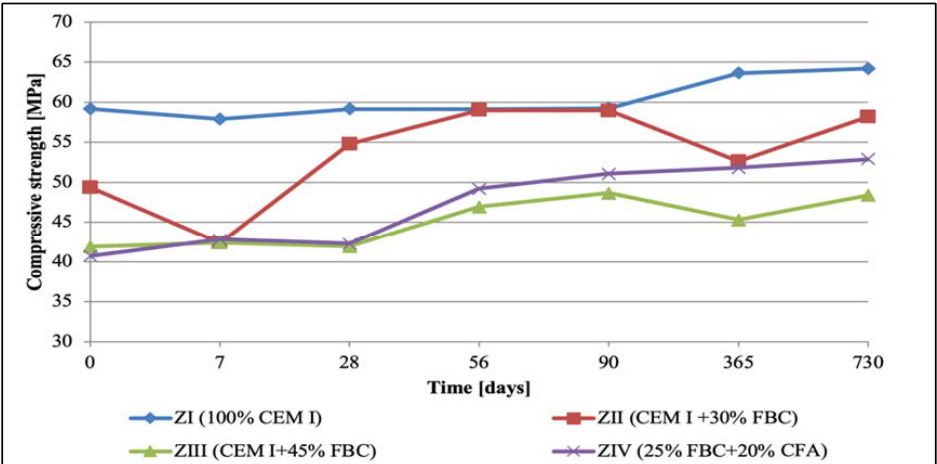
Figure 7. Compressive strength of mortars cured in water for 730 days. At the same time, tests of cement–ash mortars were conducted in an aggressive en- vironment of three solutions of hydrochloric acid with concentrations of 1, 3, and 5%, which had various pH reactions equal to: 2, 1.3, and 0.7, respectively. Observation of the corrosive environment’s impact in case of 1% hydrochloric acid solution (pH = 2) on durability of mortars tested (Figure 8) showed that between the 90th and 365th day of testing, durability of the ZII mortar was comparable to the durability of the ZI reference mortar. The higher content of fly ash in the ZIII and ZIV mortars led to reduction of the compressive strength of those mortars compared to the strength of the reference mortar (ZI). It was noticed that in the longer period of the specimens curing (between the 90th and 730th day) in the 1% solution of hydrochloric acid, the compressive strength of the ZI reference mortar dropped at the highest rate (Figure 8). This proved a beneficial effect of application of the FBC fly ash and the blend of FBC and CFA ashes to mortars exposed to 1% HCl solution for a longer time—up to 730 days of testing.